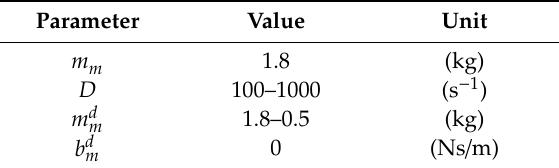
Table 1. The control